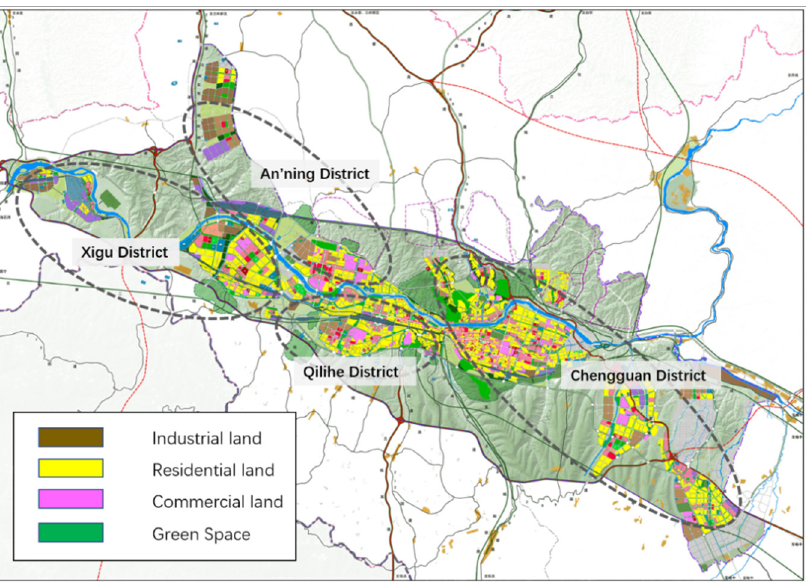
Figure 3. Lanzhou City Master Planning (2011–2020). Source: Lanzhou Nature Resource Bureau.